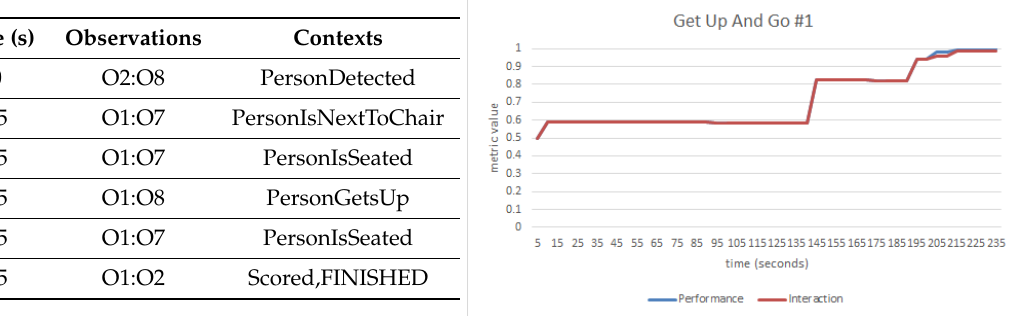
Table 13. Get Up & Go #1: (Left) Contexts and observations generated by the system. (Right) Graphical evolution of the properties values during the